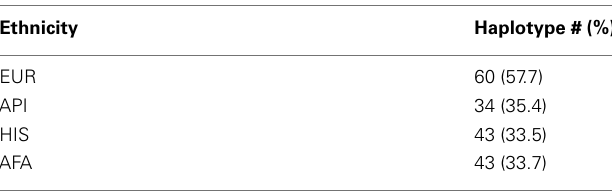
Table 2 | Numbers of different haplotypes with a significantly